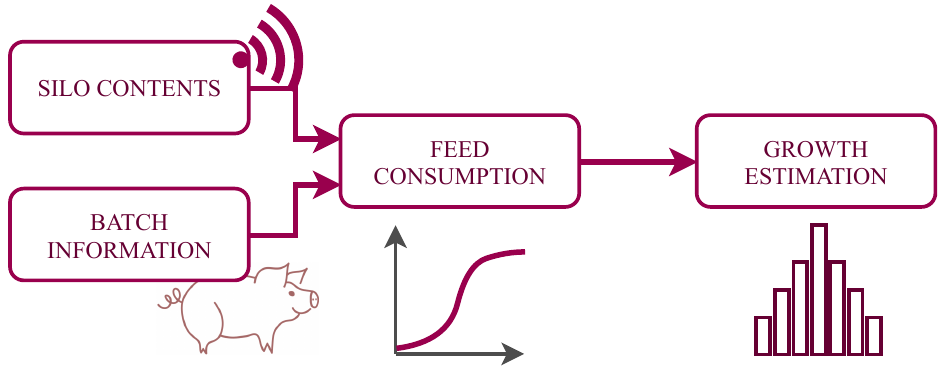
Figure 4. General data flow